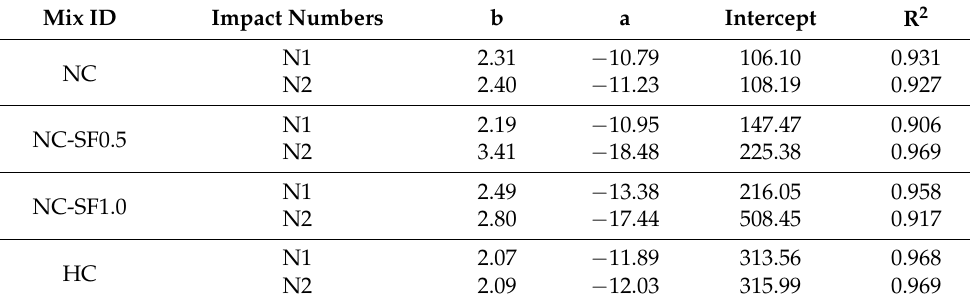
Table 5. Two parameters calculated from the Weibull analysis.